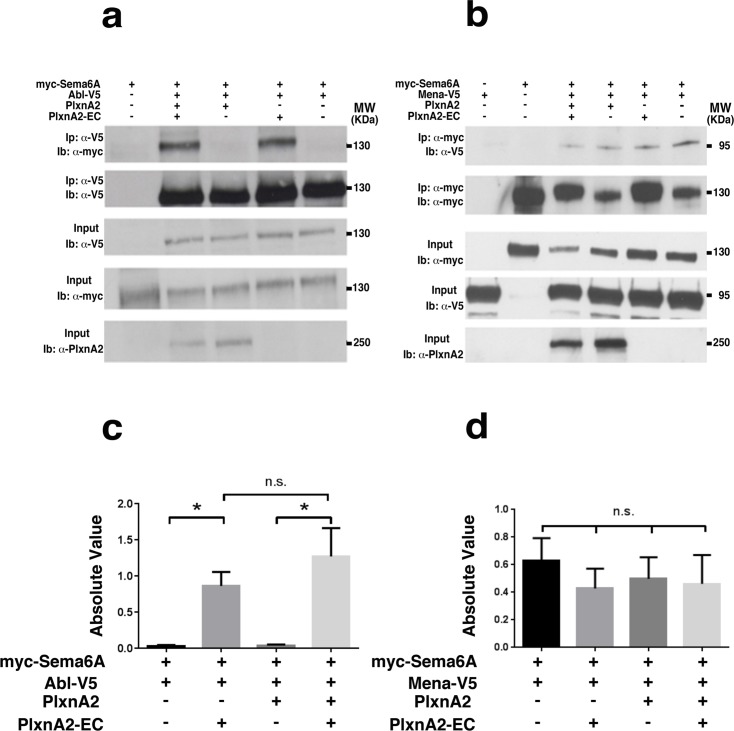
Sema6A cytoplasmic domain interacts with Abl and Mena.(A) Immunoprecipitations from untreated or PlxnA2-EC-treated COS-7 cells previously transfected with different combinations of myc-Sema6A, Abl-V5 and PlxnA2. Immunoprecipitations (Ip) were performed employing an anti-V5 antibody. Antibodies against V5, myc and PlxnA2 were used in the immunoblots (Ib). (B) Immunoprecipitations from untreated or PlxnA2-EC treated COS-7 cells previously transfected with different combinations of myc-Sema6A, Mena-V5 and PlxnA2. Immunoprecipitations (Ip) were performed employing an anti-myc antibody. Antibodies against V5, myc and PlxnA2 were used in the immunoblots (Ib). (C) and (D) Interactions were quantified by immunoblotting and densitometric analysis. Histograms represent quantification of interaction normalized to the amount of immunoprecipitated protein (Abelson-V5 for Sema6A-Abelson or Sema6A-myc for Sema6A-Mena) from three independent experiments. Students t-test *p<0,05 indicating signifiance. S6A-Abl/S6A-Abl+PlA2 p = 0.013, S6A-Abl-PlA2/S6A-Abl-PlA2+PlA2 p = 0.034. Errors bars represent standard error.